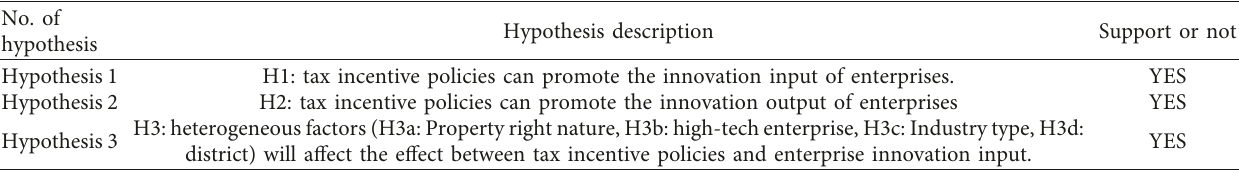
Table 9: Hypothesis validation results.